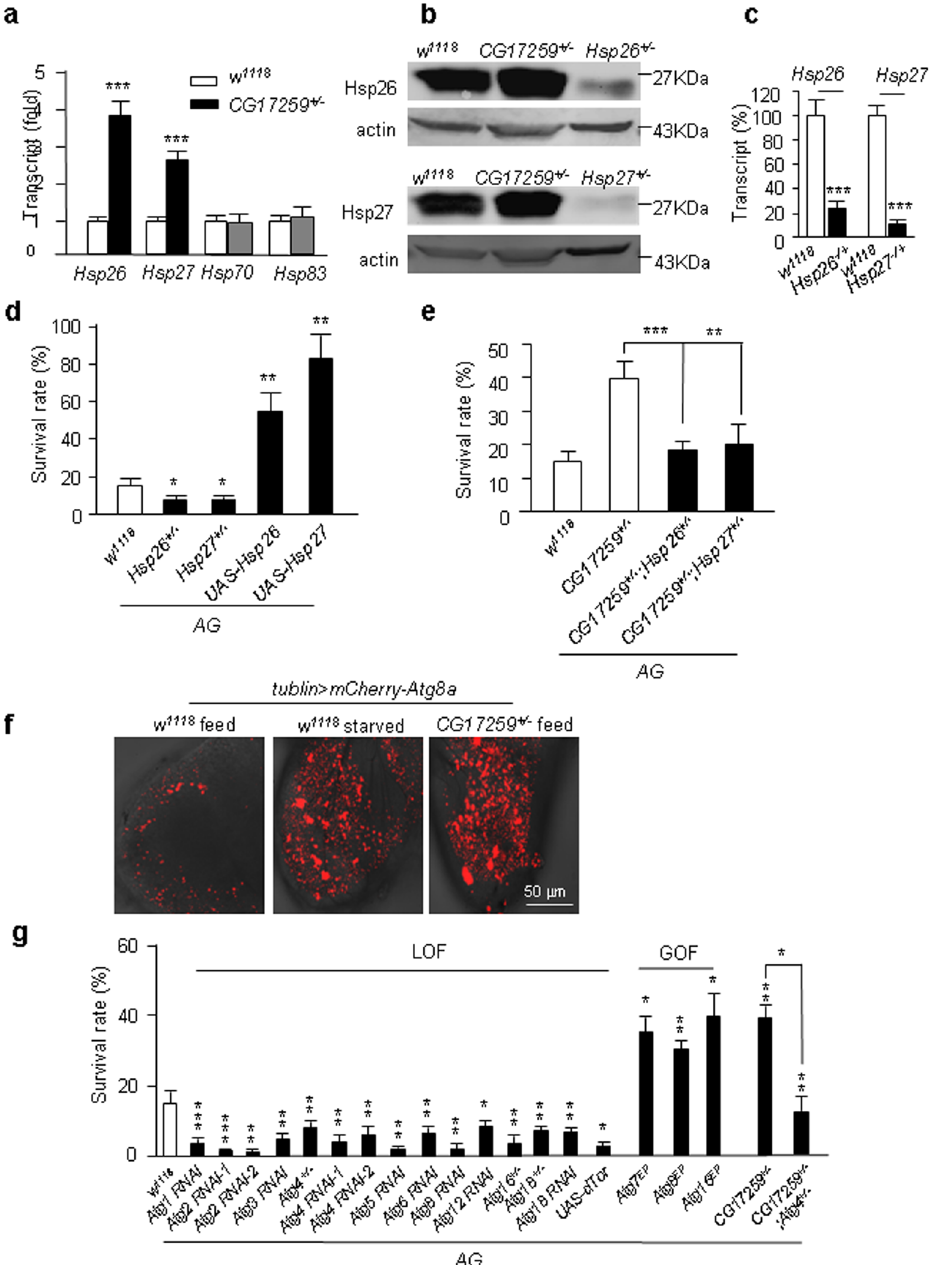
Figure 3. Characterization of the small chaperones and autophagy. ( a ) Transcription level of Hsp26 and Hsp27 in the CG17259 mutant detected by qRT-PCR. The RNAs were collected from the fly heads. The relative mRNA level of Hsp26 , Hsp27 , Hsp70 and Hsp83 in the wild type fly ( w 1118 ) was defined as 1. The means ± SD of relative transcripts. Trial n = 3. ( b ) The Western blot to detect the protein level of Hsp26 and Hsp27 in the CG17259 mutant flies. The heterozygous mutants of hsp26 and hsp27 serve as controls to indicate the specificity of the antibodies. Trial n = 3. ( c ) qPCR for Hsp26 and Hsp27 . The heterozygous mutant of Hsp26 − / + and Hsp27 − / + lines contain a third chromosome balancer (short bristle) and they are homozygous lethal. The relative levels of transcript of Hsp26 and Hsp27 to the wild type ( w 1118 ) are shown. Trial n = 3. ( d ) Survival of AG flies under the genetic background indicated. Trial n = 6. ( e ) Survival of AG flies under the genetic background indicated. Trial n = 5. ( f ) Autophagy activation determined by the in vivo reporter ( mCherry-Atg8a , the red channel). In the fed condition, the fat bodies of wild type ( w 1118 ) showed minimum activation of autophagy, but autophagy was activated under the starvation condition. This response serves as a positive control for autophagy activation. In the CG17259 mutant flies, autophagy was activated under the fed condition. Trial n = 2. ( g ) Survival of AG flies under different autophagy mutant backgrounds. The RNAi and mutant of the Atg genes (as indicated as LOF) all showed enhancing effect on lethality of AG flies; whereas up-regulation of several Atg genes (GOF) all showed a rescue effect on lethality of AG flies. Trial n =